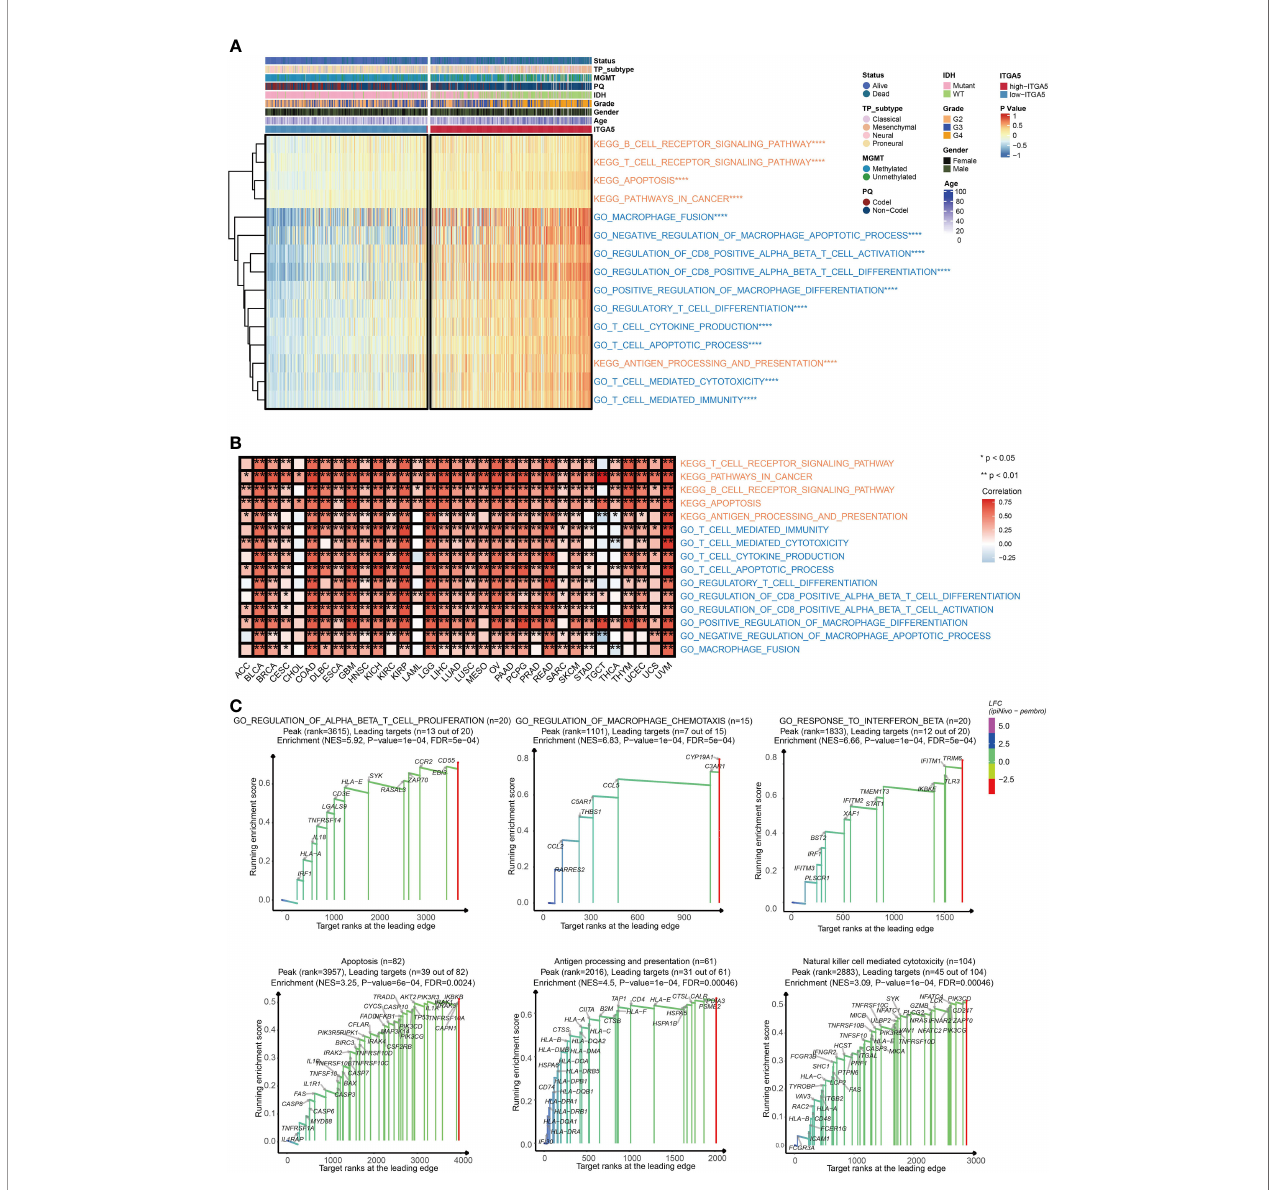
FIGURE 3 | The functional annotation based on ITGA5 expression. (A) The heatmap for gene set variation analysis of the ITGA5 from the TCGA. *P < 0.05, **P < 0.01, ***P < 0.001, ****P < 0.0001. (B) The heatmap showing the relationship between the above pathways and ITGA5 in the TCGA pan-cancer cohorts. (C) GSEA plots for several signaling pathways positively regulated by